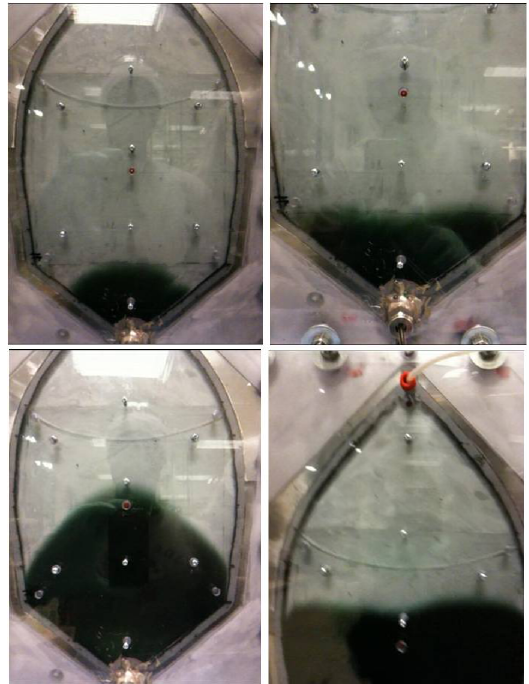
Figure 21. Flow distributions at the beginning ( top ) and middle ( bottom ) of the flow cell for the parallel plate ( left ) and the deflected plate ( right ) flow cells. Reproduced from